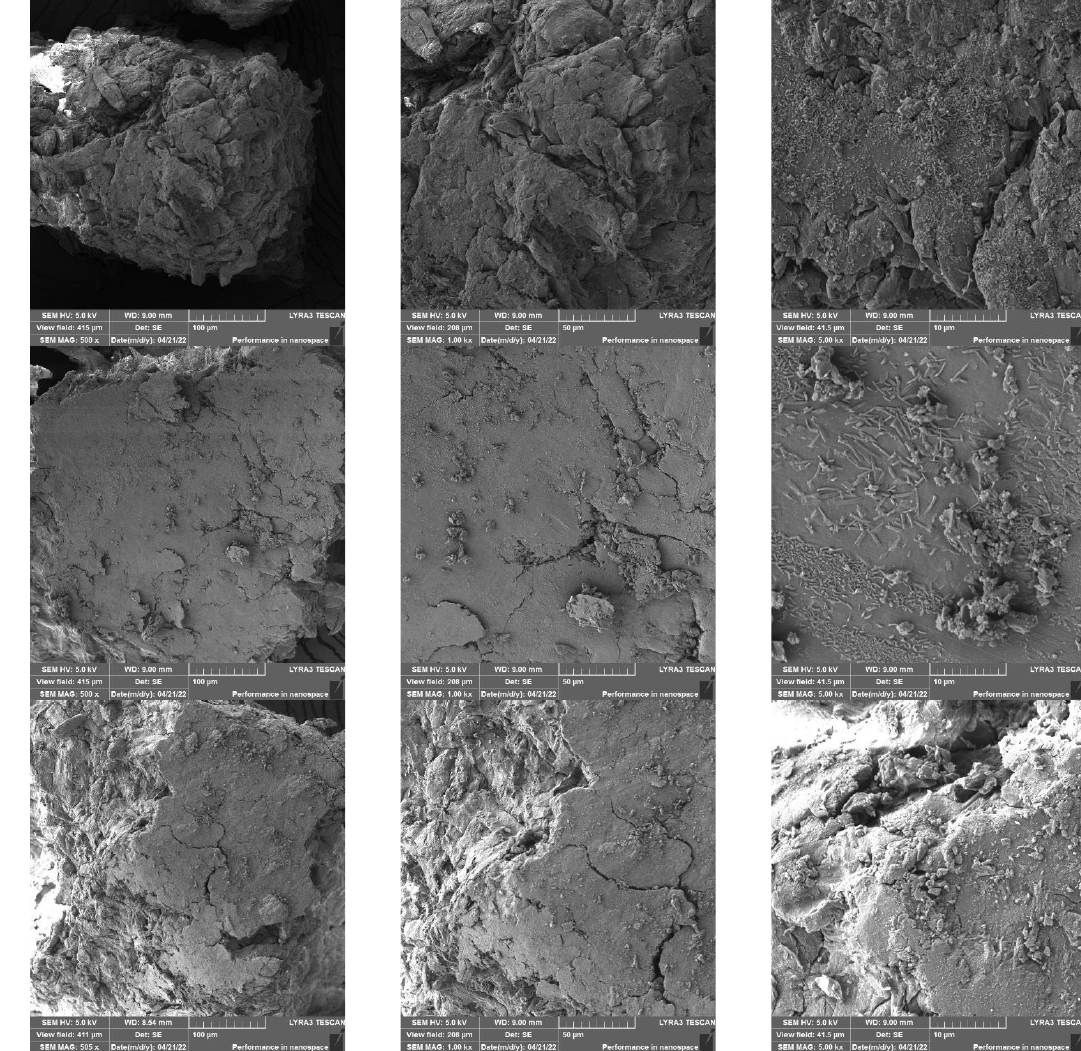
Figure 9. SEM images of granules containing MX applied in 7 (top), 14 (middle), and 27 (bottom) impregnation cycles at 500× ( left ), 1000× ( center ) and 5000× ( right ) magnification.